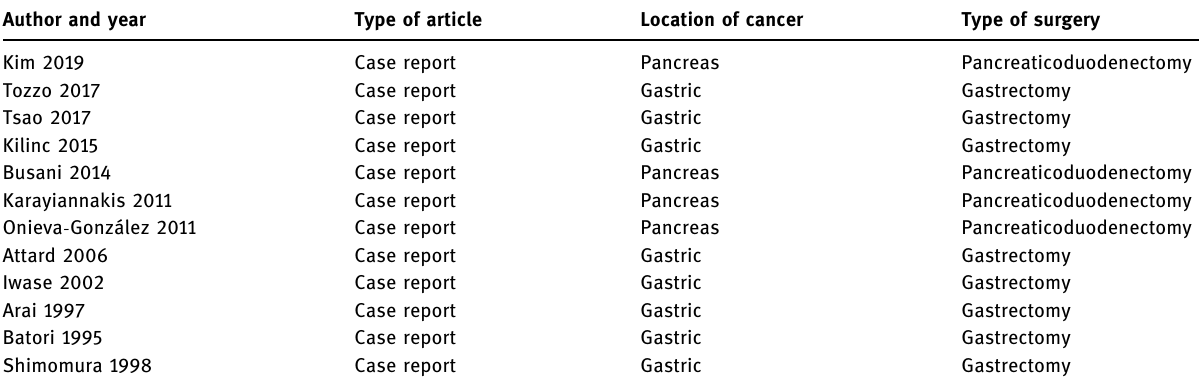
Table 1: Review of literature: case report of Wernicke ’ s encephalopathy after oncologic gastrointestinal surgery Author and